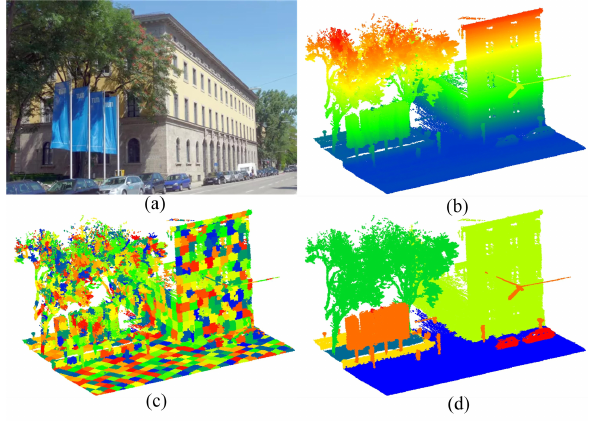
Figure 8. (a) Real scene. (b) MLS point clouds. (c) Supervoxels of the point clouds. (d) Classified sub-scene of test